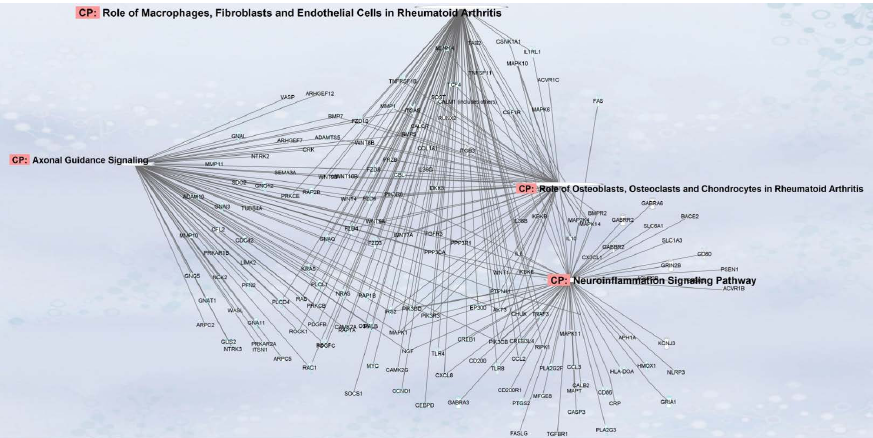
Figure 3. The plot of genes predicted to be affected by the miRNAs differed significantly between patients without and with corneal nerve loss using